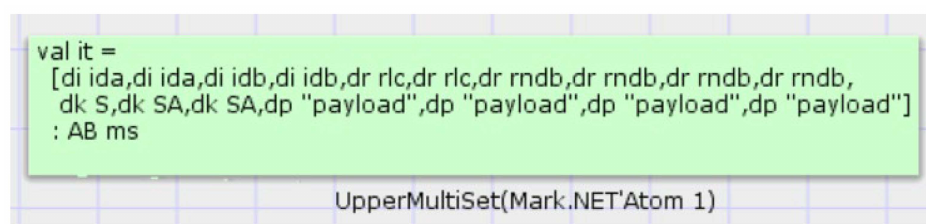
Figure 8. Identity authentication result on the receiver.